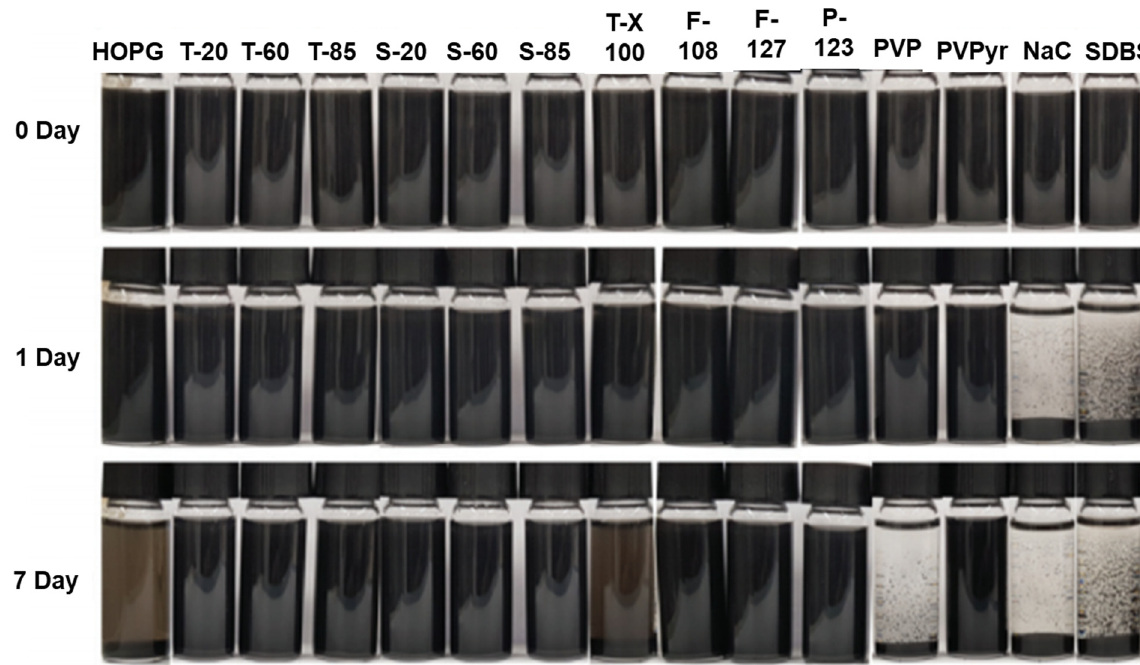
Figure 4. Photographic images of GO dispersions in different solvents prepared by conventional and new methods. Reproduced with permission from [75].